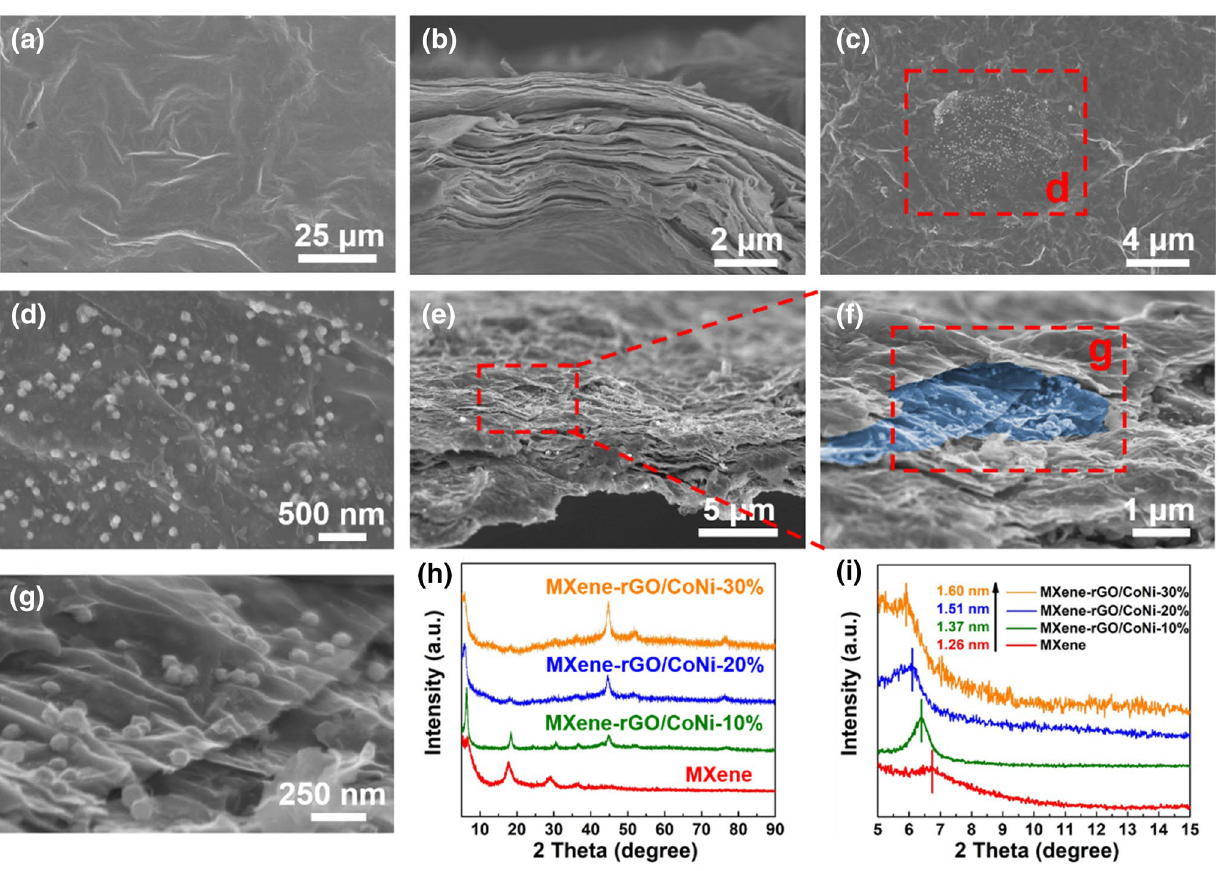
Fig. 3 a SEM image and b cross-sectional SEM image of pure MXene film; c , d SEM images and e – g cross-sectional SEM images of MXene- rGO/CoNi film; h XRD patterns of MXene, MXene-10%rGO/CoNi, MXene-20%rGO/CoNi and MXene-30%rGO/CoNi; i magnification of XRD patterns in h